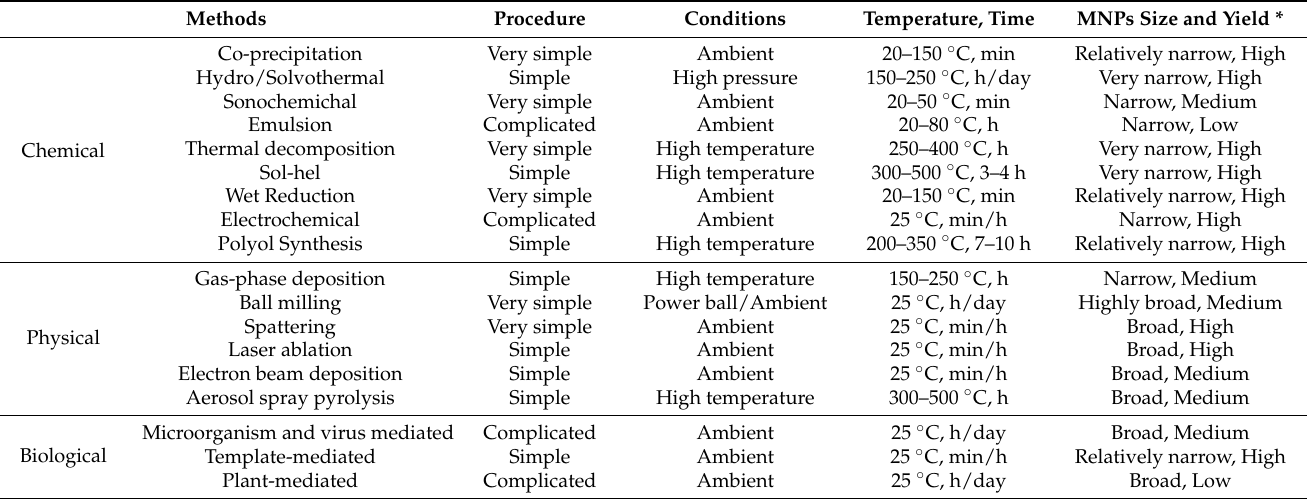
Table 1. MNP synthesis